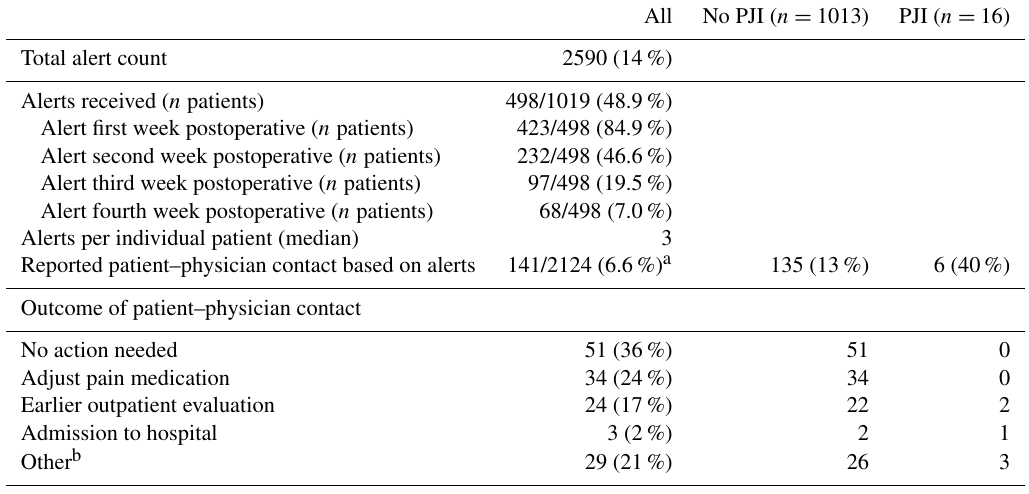
Table C1. Actions taken on algorithm-based alerts generated by the app from 18437 daily reports.